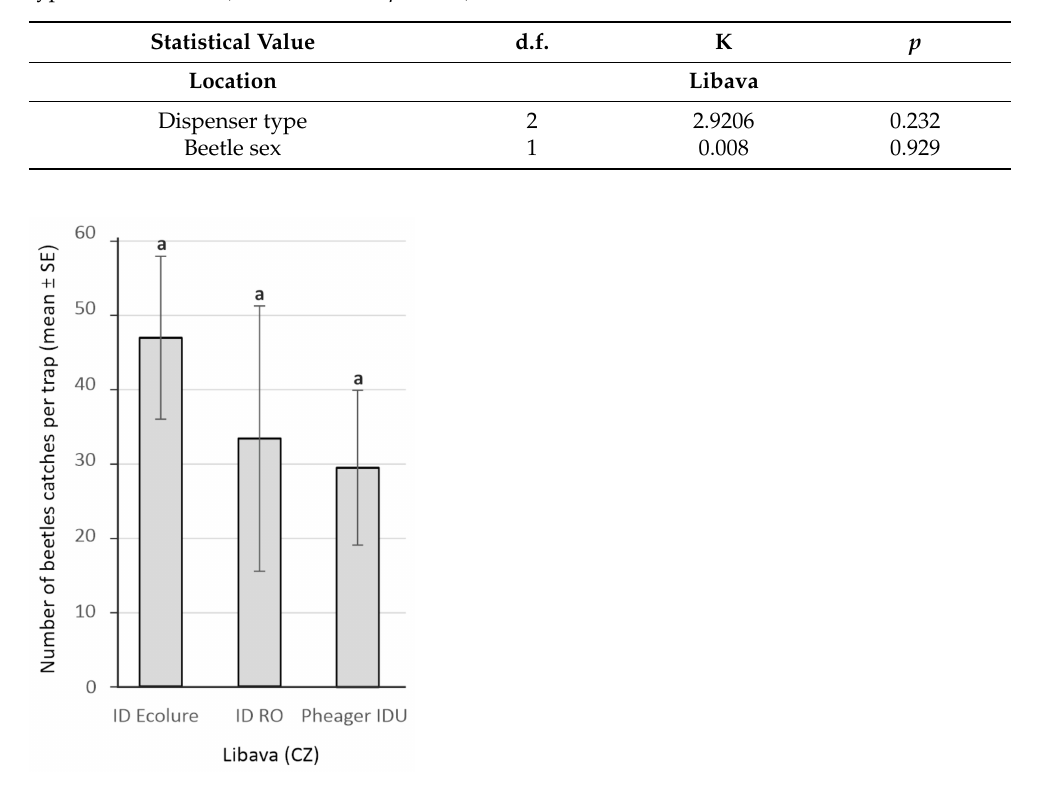
Figure 4. Comparison of Ips duplicatus captures obtained on the second field experiment for traps baited with different dispenser types. Bars with the same letters indicate no significant differences (Dunn test: p <